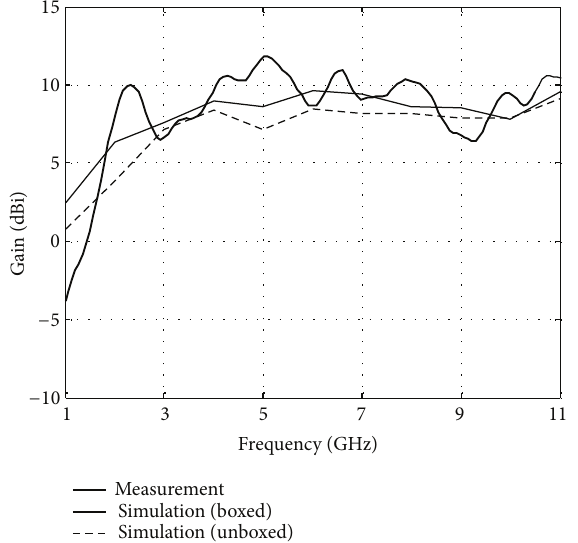
Figure 6: Gain performance of the antenna for simulation (both boxed and unboxed) and actual measurement cases.